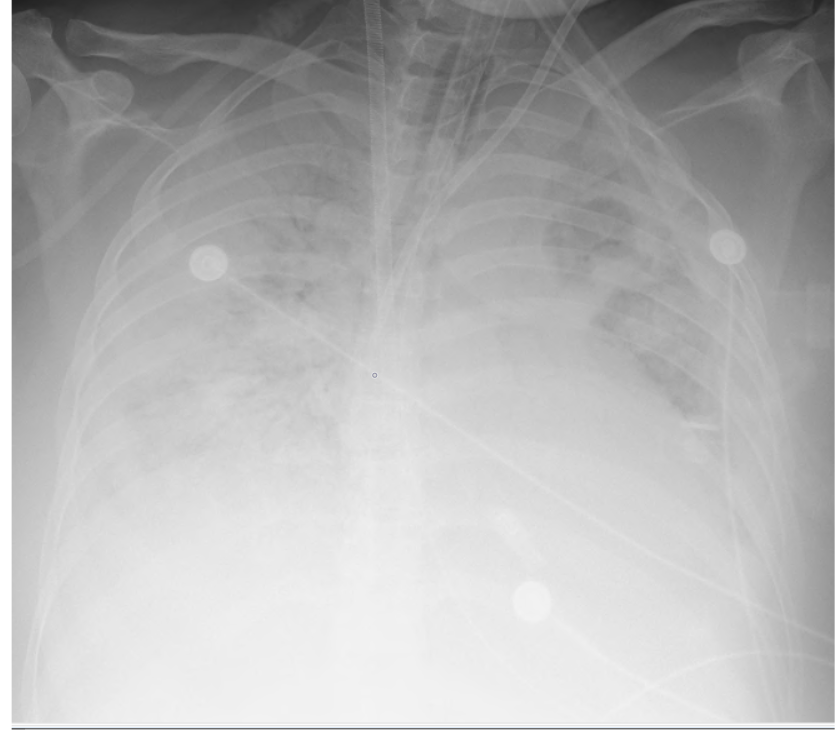
Figure 2. Chest X-ray showing diffuse opacity and infiltrates in a postpartum woman treated with